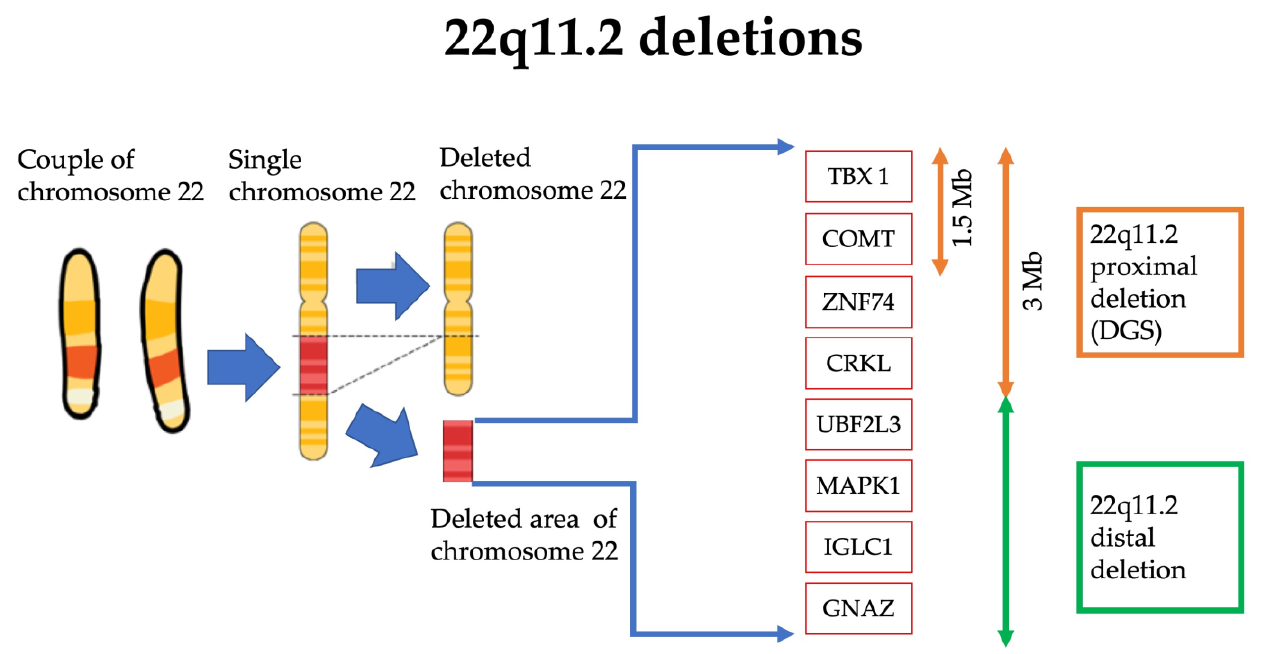
Figure 1. Schematic representation of the 22q11.2 deleted region of the chromosome 22 in DGS. The dimension of the deleted section (in red) is amplified for visual and graphical reasons.